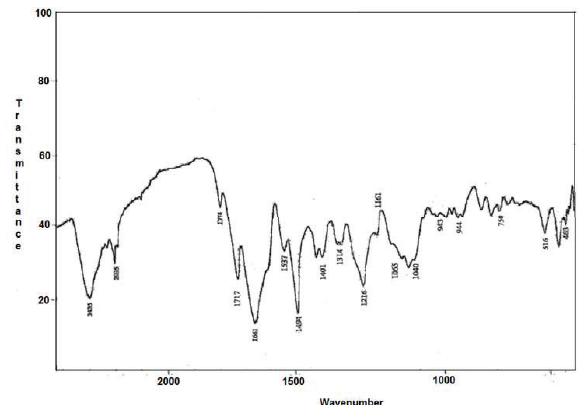
Figure 4. FTIR spectrum in unit cm (cid:3) 1 of PAI- nanocomposite films 5a .